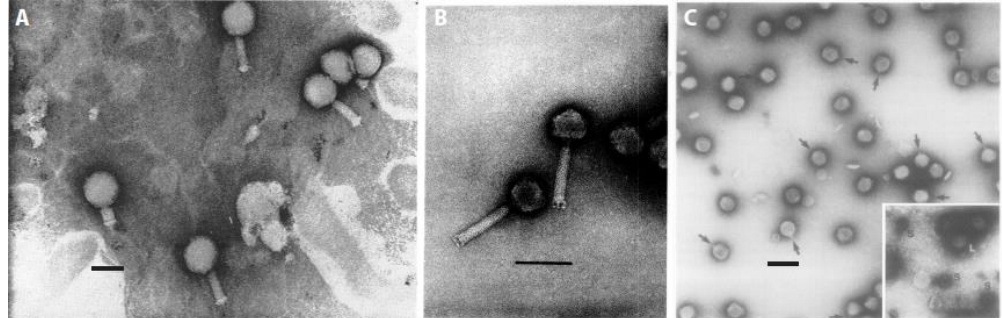
Figure 2. Micrographs of distinct serological types of myxophages. ( A ) Phage Mx1 (Reproduced with permission from [34]); ( B ) phage Mx4 (Reproduced with permission from [47]); and, ( C ) phage Mx8 (Reproduced with permission from [39]). Inset, large and small phage particles after centrifugation are shown. Phage Mx9 is described as morphologically very similar to Mx8 [39]. Scale bars represent 100 nm each.